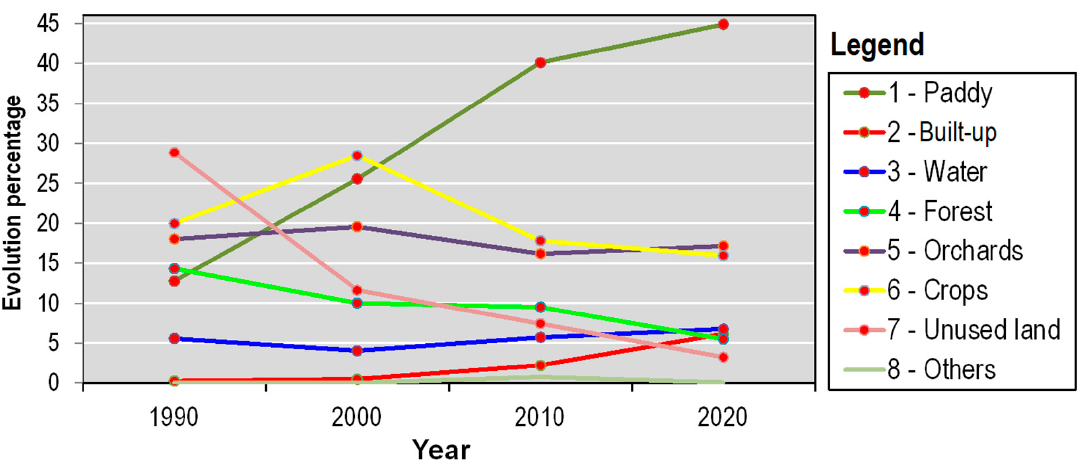
Table 6. The magnitudes and annual rate changes for the LULC classes in the Dong Thap Muoi area for the period 1990–